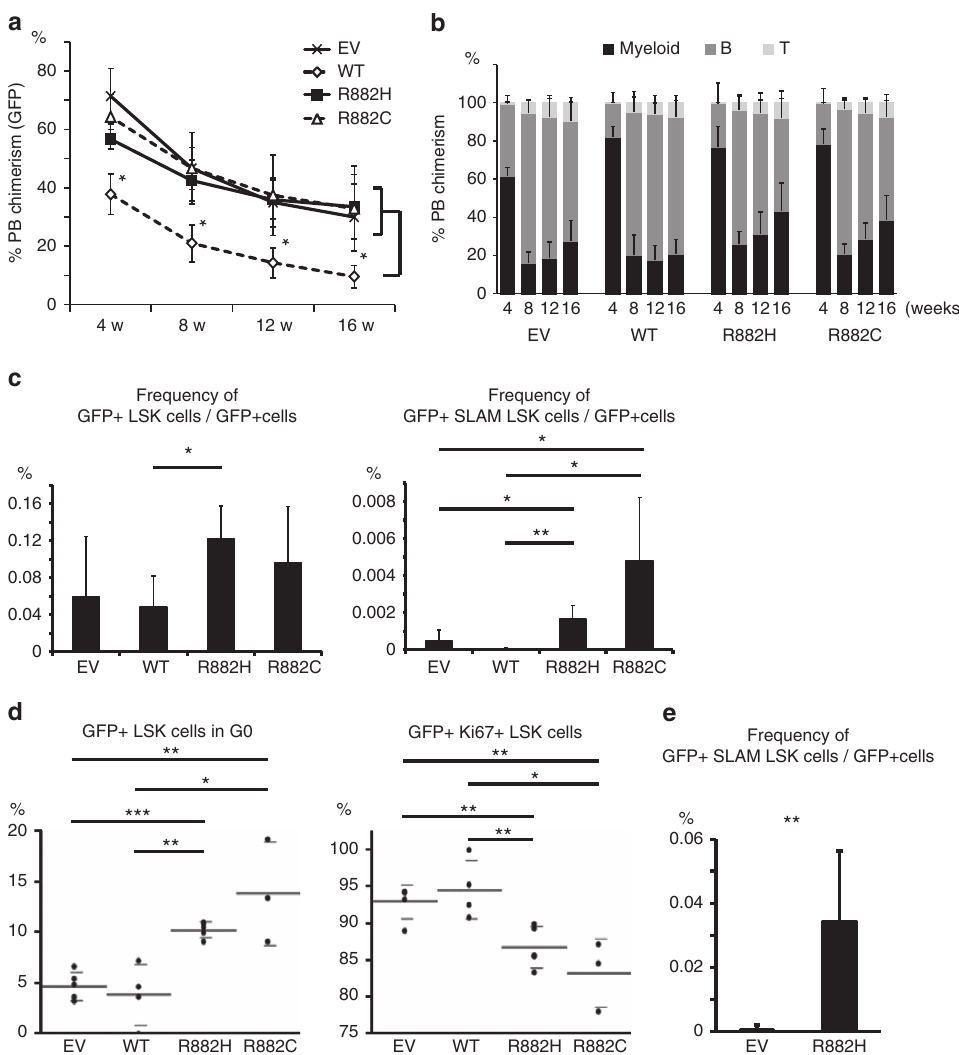
Figure 1 | Effect of exogenous expression of DNMT3A R882 mutation in primary mouse bone marrow cells. ( a ) Contribution of EV, WT, R882H and R882C to PB chimerism in primary competitive transplants, measured at monthly intervals. ( N ¼ 5–6 mice). P values were calculated using two-tailed unpaired t -test. ( b ) PB lineage distribution of mice transplanted with EV-, WT-, or R882 mutant-transduced cells. Shown are percentage of donor-derived (GFP þ ) myeloid cells, B cells and Tcells, measured at monthly intervals. ( N ¼ 5–6 mice). ( c ) Cumulative data of the frequency of GFP þ LSK cells in GFP þ cells (left) and GFP þ SLAM LSK cells in GFP þ cells (right); N ¼ 4–5 mice. P values were calculated using two-tailed unpaired t -test. ( d ) Cell cycle analysis shows the percentage of cells in G0 status is increasing (left) and the percentage of Ki67 positive cells is decreasing in R882 mutant-transduced HSCs (gated by GFP þ LSK) (right) compared with EV- and WT-transduced ones. (EV and R882H: N ¼ 5; WT: N ¼ 4; and R882C: N ¼ 3 mice). P values were calculated using two-tailed unpaired t -test. ( e ) Cumulative data of the frequency of GFP þ SLAM LSK cells in GFP þ cells in secondary transplantation. (EV: N ¼ 5; WT: N ¼ 4; and R882H: N ¼ 10 mice). P values were calculated using two-tailed unpaired t -test. EV indicates empty vector; PB, peripheral blood; w, weeks; WT, wild-type; SLAM LSK, CD150 þ , CD48 (cid:2) , Lineage (cid:2) , Sca1 þ , c-kit þ . Data are mean ± s.d. values. * P o 0.05, ** P o 0.01, *** P o